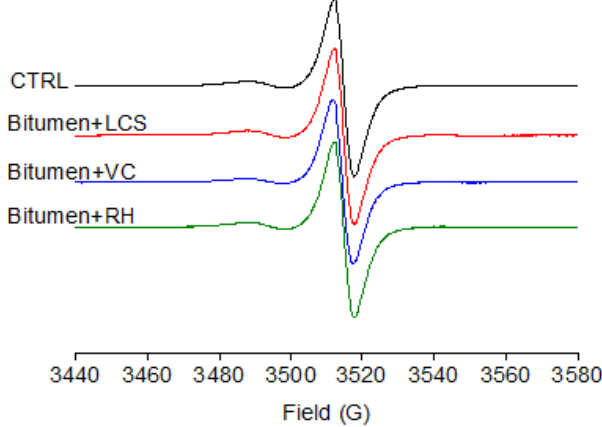
Figure 5. X-band EPR spectra of unaged asphaltene samples mixed with 2% w/w of antioxidants registered at room temperature. CTRL indicates the control sample with no antioxidant added.